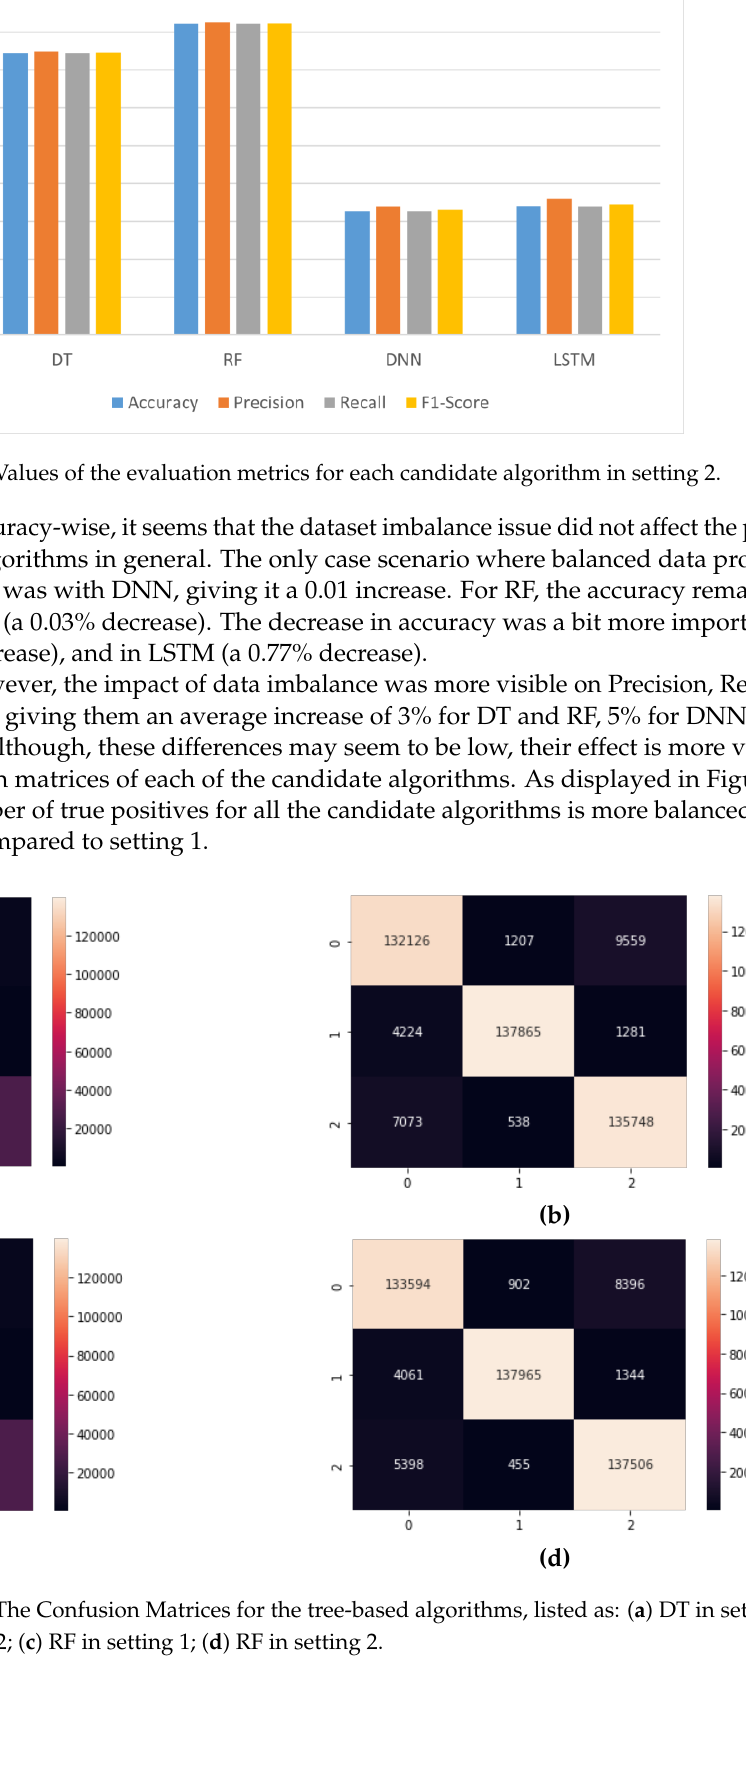
Figure 6. Values of the evaluation metrics for each candidate algorithm in setting 1.